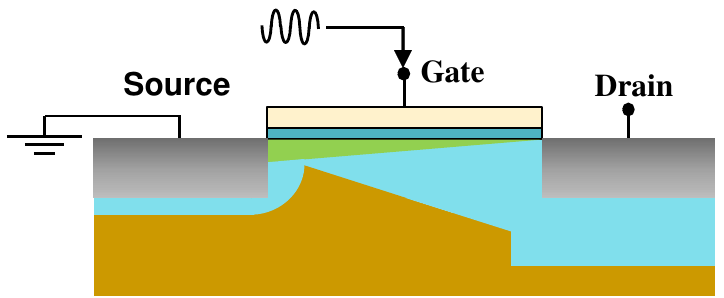
Figure 1. Cross-sectional diagram of